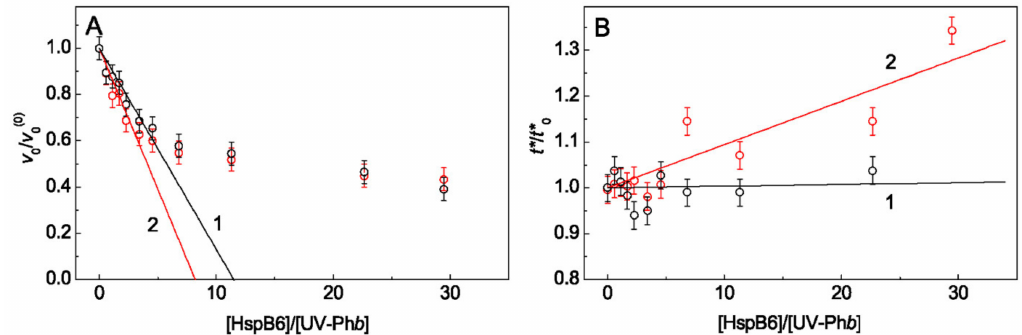
Figure 2. E ff ect of HspB6 on the kinetic parameters of UV-Ph b (0.25 mg / mL) aggregation in the absence and in the presence of 0.1 M Arg at 37 ◦ C. ( A ) The dependences of the relative initial rate of UV-Ph b aggregation for the stage of aggregate growth, v 0 / v 0(0) , and ( B ) the relative value of the nucleation stage duration, t* / t* 0 , on the ratio of molar concentrations of HspB6 and UV-Ph b . Points are experimental data. The solid lines in panel A are calculated from Equation (2). Curves 1 and 2 in panels ( A , B ) are obtained in the absence and in the presence of 0.1 M Arg, respectively.